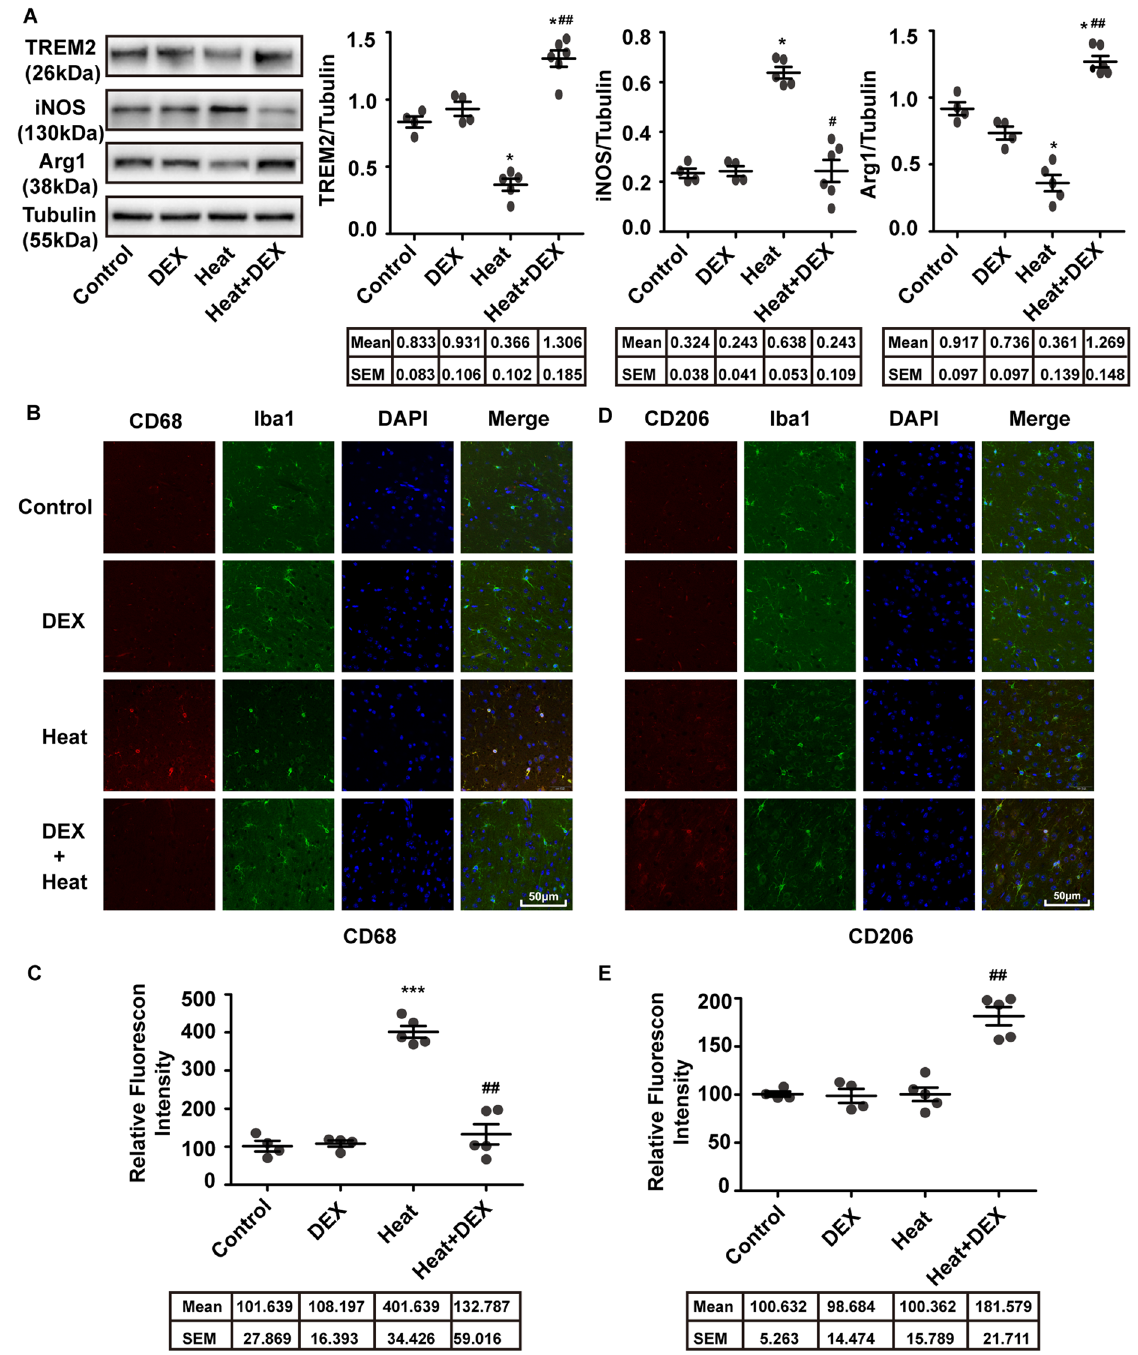
Figure 2. DEX promotes the transformation of mouse brain microglia to the neuro-protective type in heatstroke. ICR mice were exposed to an ambient temperature of 41 ± 0.5 °C until Tc > 42.7 °C (heatstroke onset), and then injected intraperitoneally with 25 µg/kg DEX (heat + DEX group) or 0.9% saline (heat group), followed by a 12-h recovery at an ambient temperature of 23 ± 1 °C. ( A ) The expression of TREM2, iNOS, and Arg1 in the cerebral cortex was determined by Western blotting. ( B ) Microglia with nerve-damaging functions in the cerebral cortex were visualized by immunofluorescence staining of Iba1 and CD68 at a magnification of X-400. ( C ) Bar graphs show the semi-quantification of the relative fluorescence intensity of CD68 and Iba1 in microglia. ( D ) Microglia without nerve damaging functions in the cerebral cortex were visualized by immunofluorescence staining of Iba1 and CD206 at a magnification of X-400. ( E ) Bar graphs show the semi- quantification of the relative fluorescence intensity of CD206 and Iba1 in microglia. The data are shown as the mean ± SEM of three independent experiments. Statistical analysis: Two-way ANOVA. * p < 0.05 vs. Control. # p < 0.05, ## p < 0.001 vs.